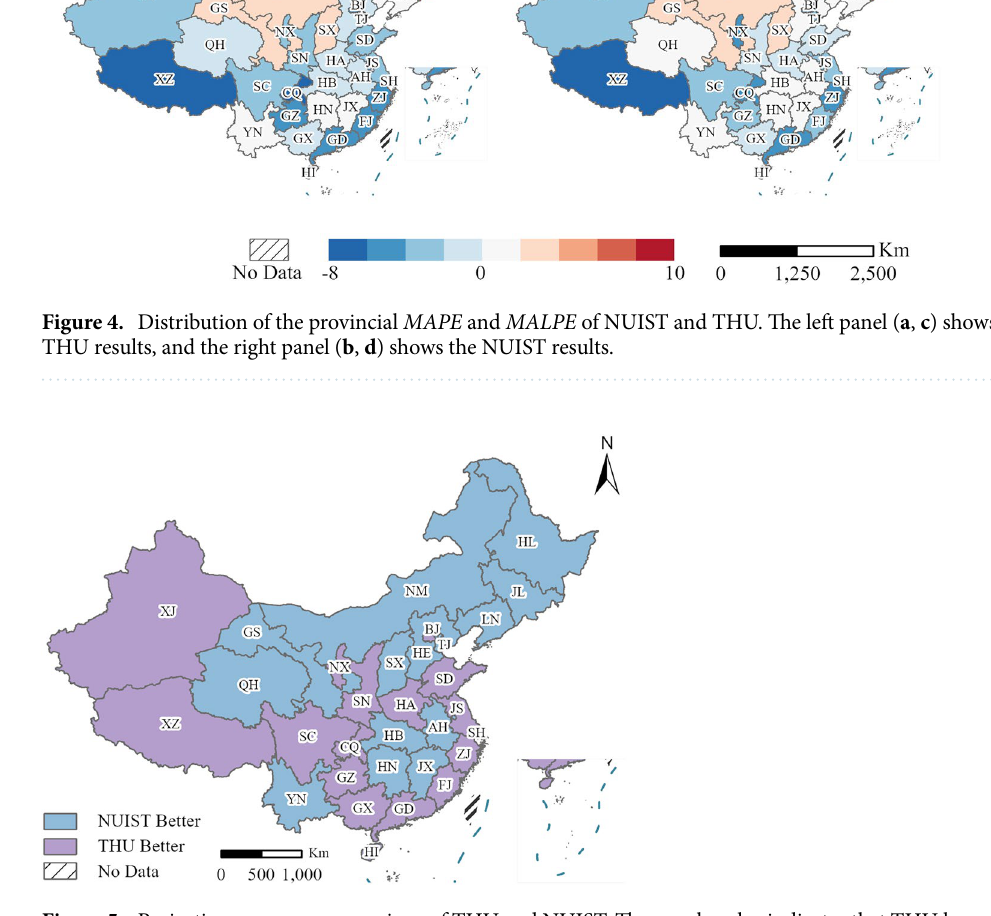
Figure 5. Projection accuracy comparison of THU and NUIST. The purple color indicates that THU has a lower MAPE than NUIST, and the blue color indicates that NUIST has a lower MAPE than THU in a particular